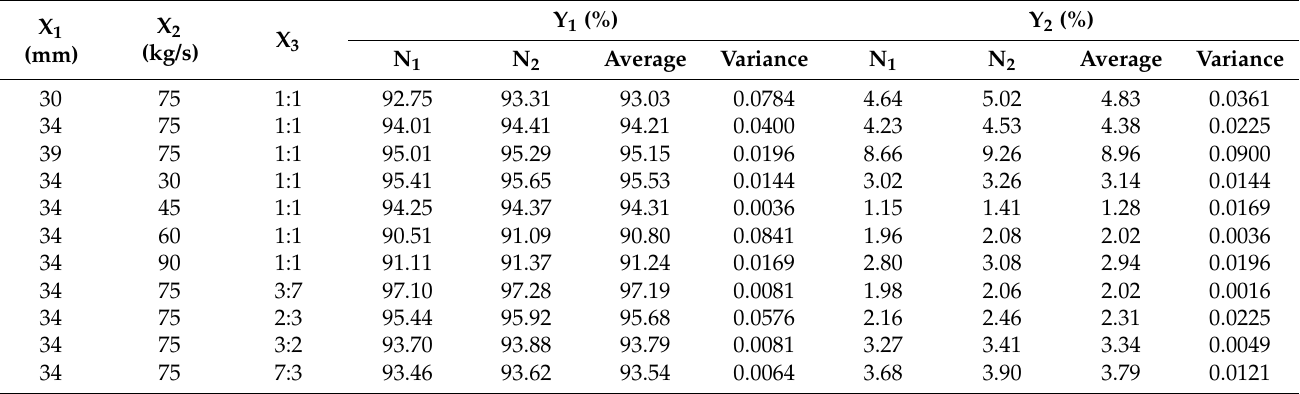
Table 7. Variance analysis of the experimental